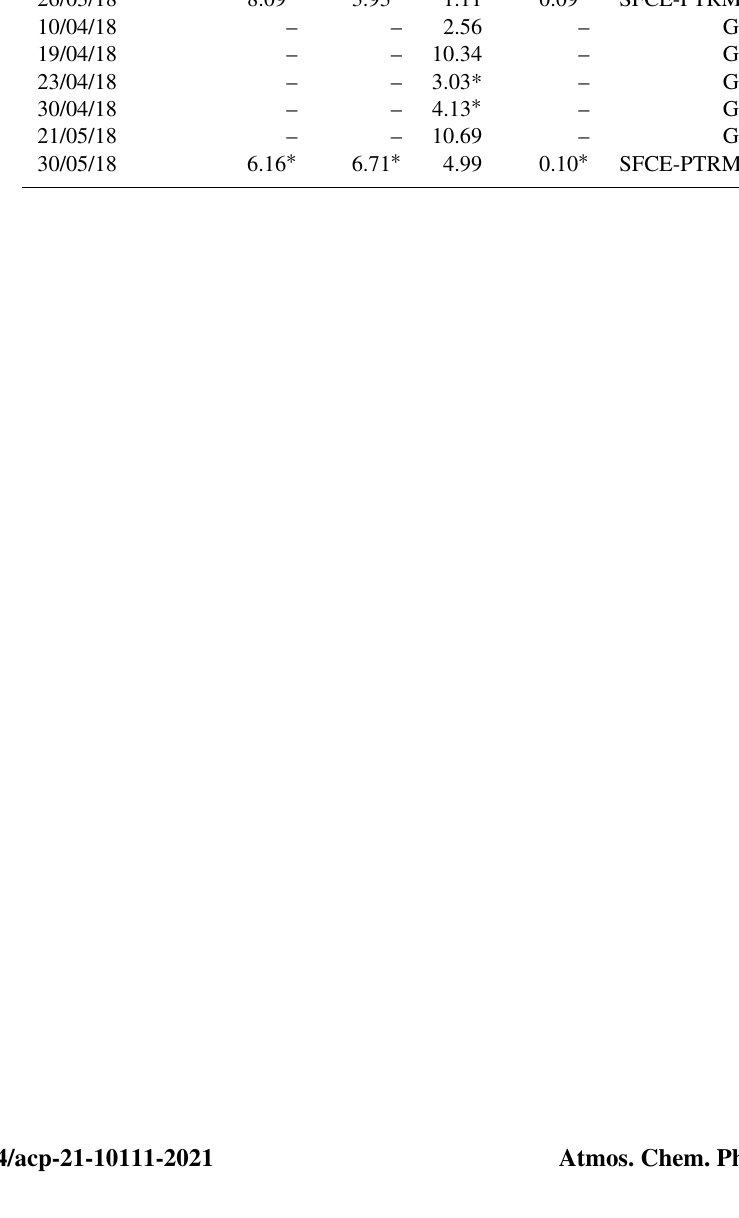
cp ) ) and molar volume ( V b ) used in calculations of sea- d ( 1 /T)